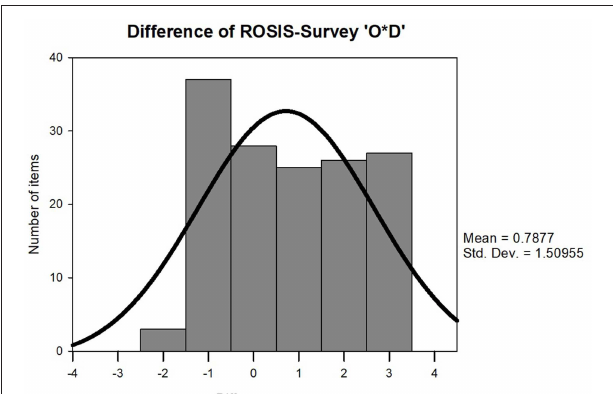
scale of 1–5 was chosen instead of 1–10, and each ROSIS item was re-classified into the 1–5 grades. A lower grade indicates